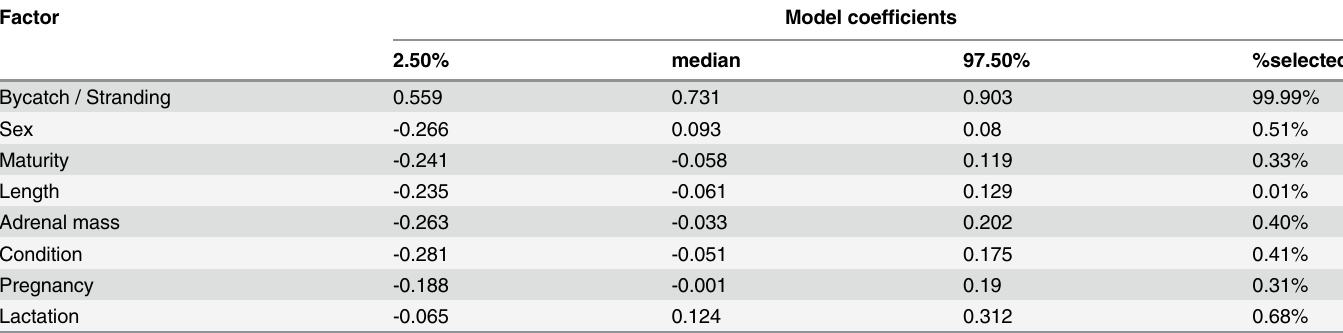
Table 1. Model averaged coef fi cients for factors associated with blubber cortisol, median, and 95% probability interval values.